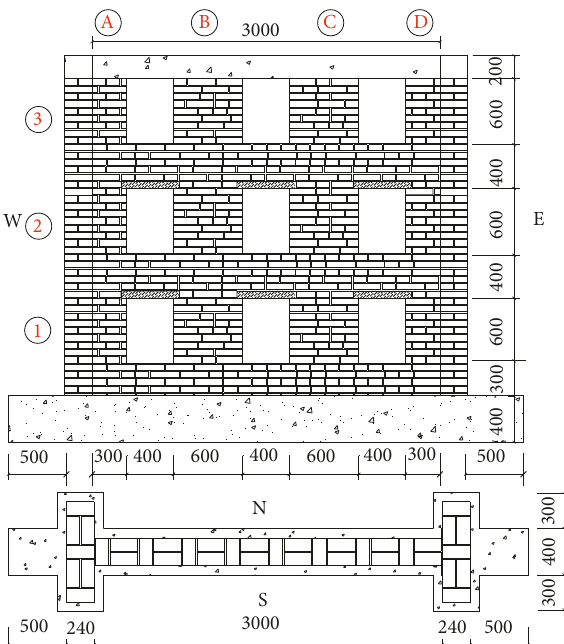
Figure 1: Description and Segmentation of multistorey masonry wall (mm) (number-XX represents spandrels and number-X represents